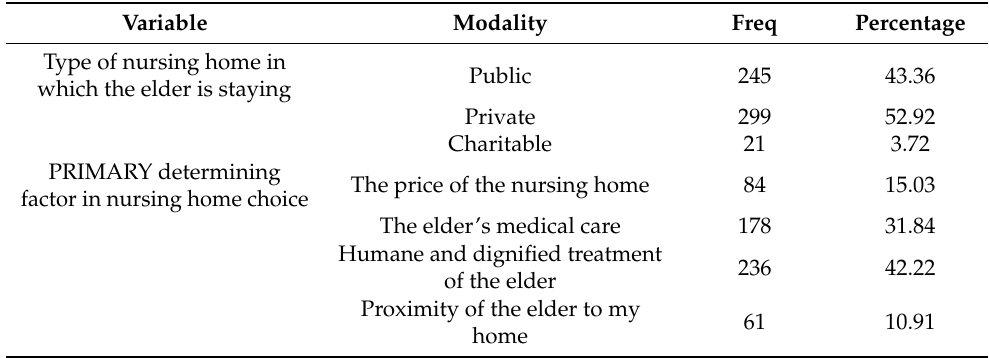
Table 4. Determining factors in the nursing home